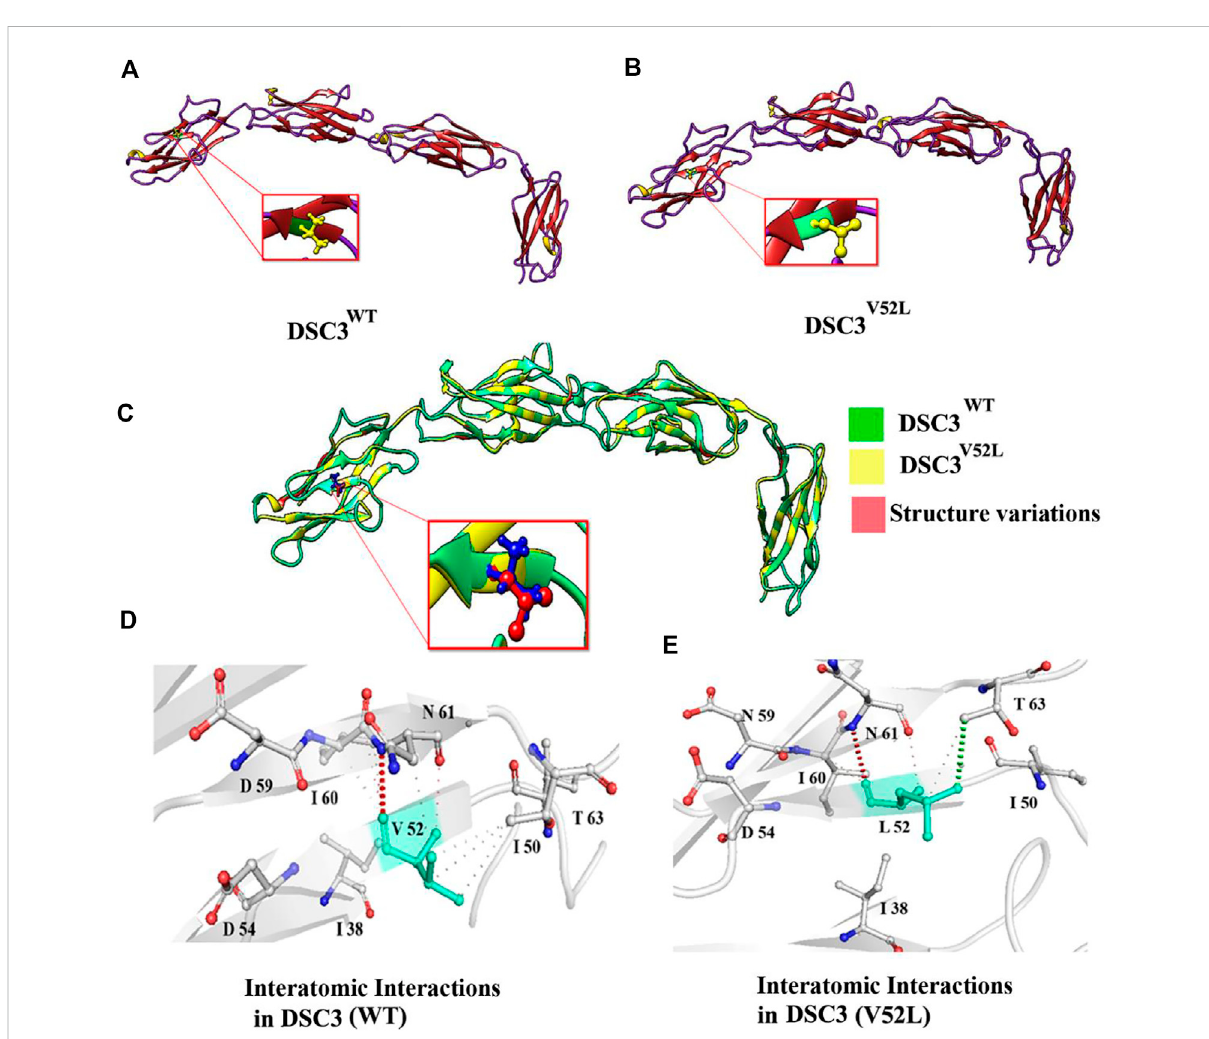
FIGURE 2 Three-dimensional structure of Desmocollin-3 protein and Interatomic interaction of Val52 and Leu52 with surrounding residues in both wild type and mutant Desmocollin3. (A,B) Representing structural 3D modeling for the DSC3 WT and DSC3 MU proteins. (C) Illustrating the superposed structure of DSC3 WT (green) and DSC3 MU (yellow) structures shows the difference (red) in overall con fi rmation due to the p. Val52Leu mutation. (D) Representing interatomic interaction of Val52 with surrounding residues in the DSC3 WT protein. (E) Showing the interatomic interaction of Leu52 with surrounding residues in DSC3 MU (p.Val52Leu)